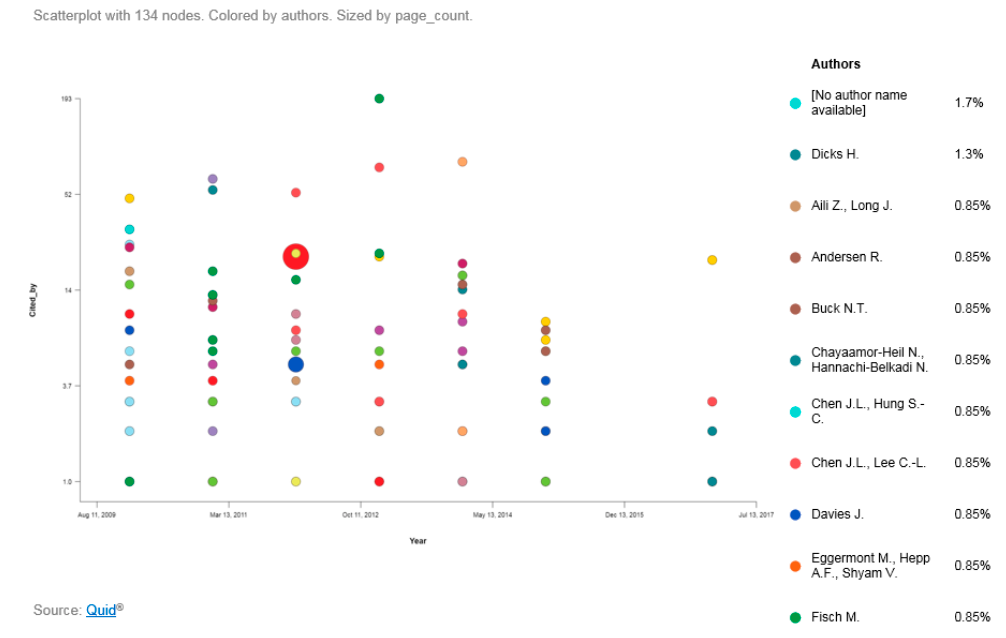
Figure 8. Publications between 2009 and 2017 colored by authors. Size of circle shows page count. There are a large number of authors publishing in the field of biomimetics with few sustained efforts.